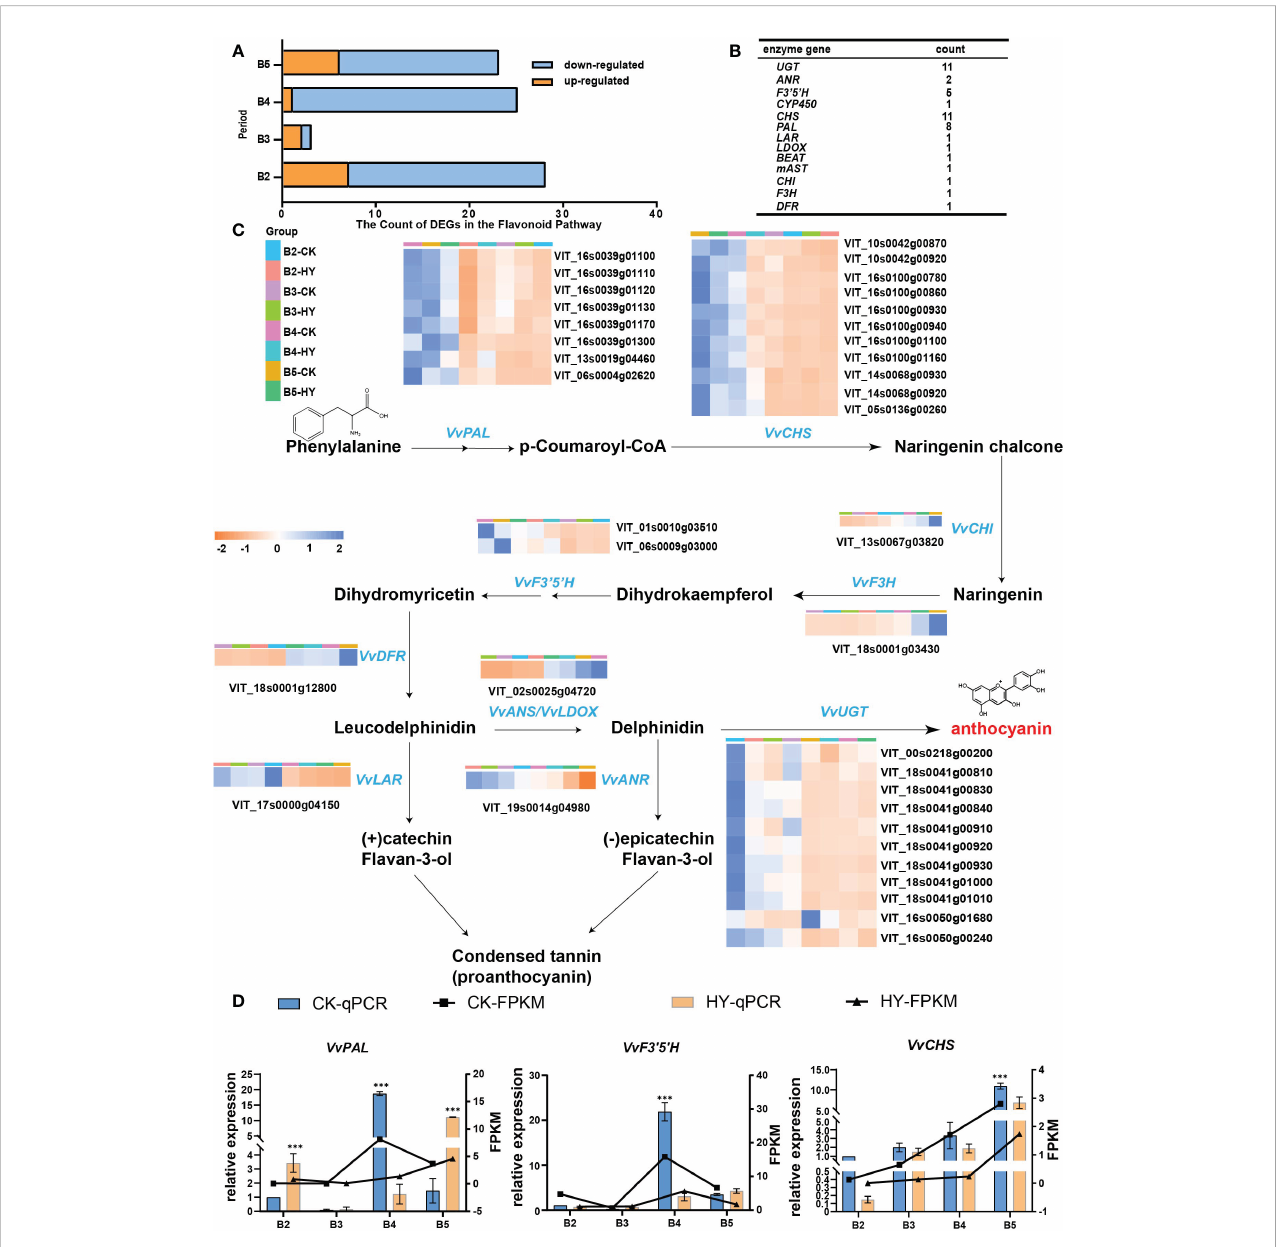
FIGURE 5 Screening and identi fi cation of enzymes. (A) Hyperoside-induced fl avonoid metabolism pathway in Gemstone seedless grape fruit.Yellow represents up- regulated and blue represents down-regulated. (B) Data on the genes in the fl avonoid biosynthesis pathway that were downregulated. (C) The pathway process in which the enzyme is located. Heat map illustrating changes in the anthocyanin metabolic pathways-related differentially expressed genes (DEGs) after treatment with hyperoside. (D) The gene expression levels of three enzymes (VvPAL, VvCHS, and VvF3 ’ 5 ’ H) were determined by RT-qPCR. P< 0.05 and P< 0.01 are denoted, respectively, by the symbols * and